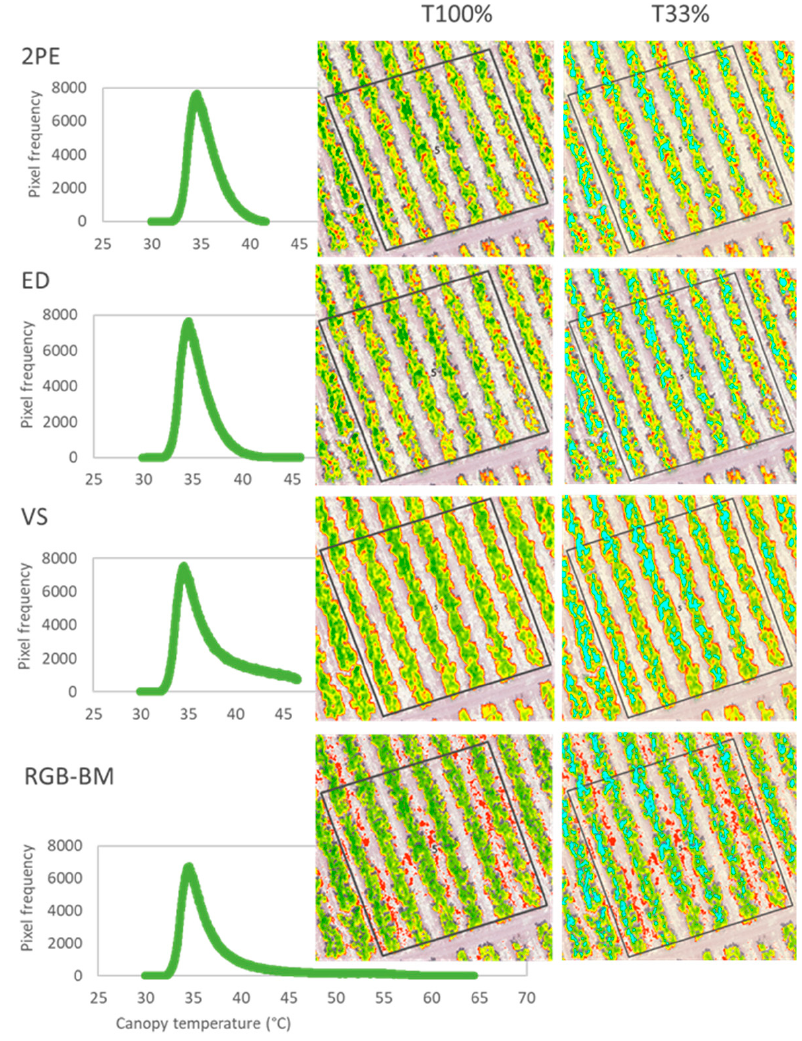
Figure 5. Canopy temperature histogram of the whole orchard for the 2-pixel erosion (2PE), edge detection (ED), vegetation segmentation (VS), and RGB binary masking (RGB-BM) canopy extraction methods on 12 August 2019. Images of all extracted canopy temperature pixels (T100%) of the management cell (MC) 5 (left image column) and the highlighted (turquoise) coolest 33% of canopy temperature pixels (T33%) (right image column) for all canopy extraction meth- ods.